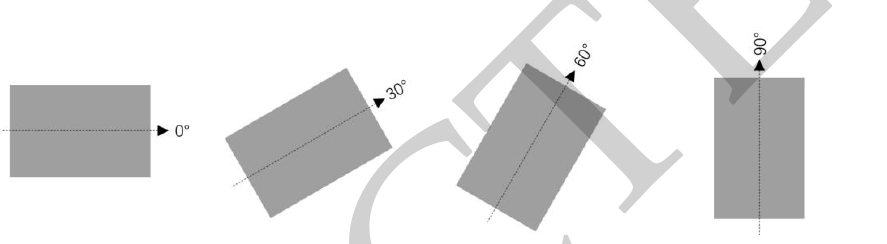
Figure 11. Setting of building angle in energy consumption simulation. Table 8. Comprehensive energy consumption in different orientations.